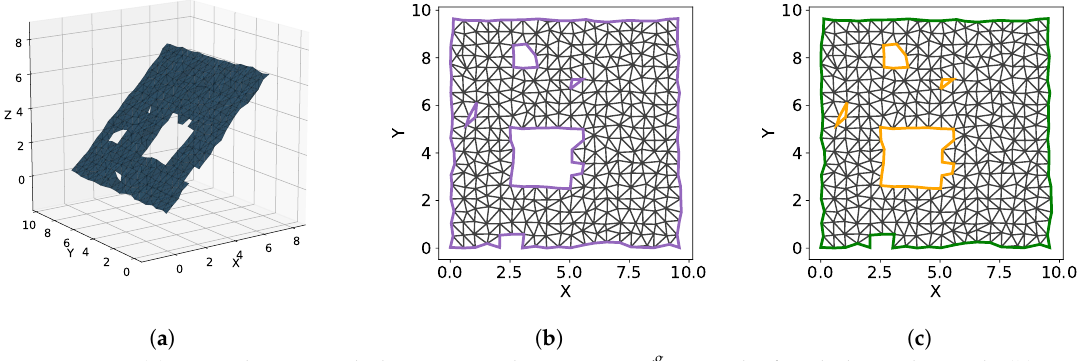
. Note the four holes in the mesh; ( b ) i